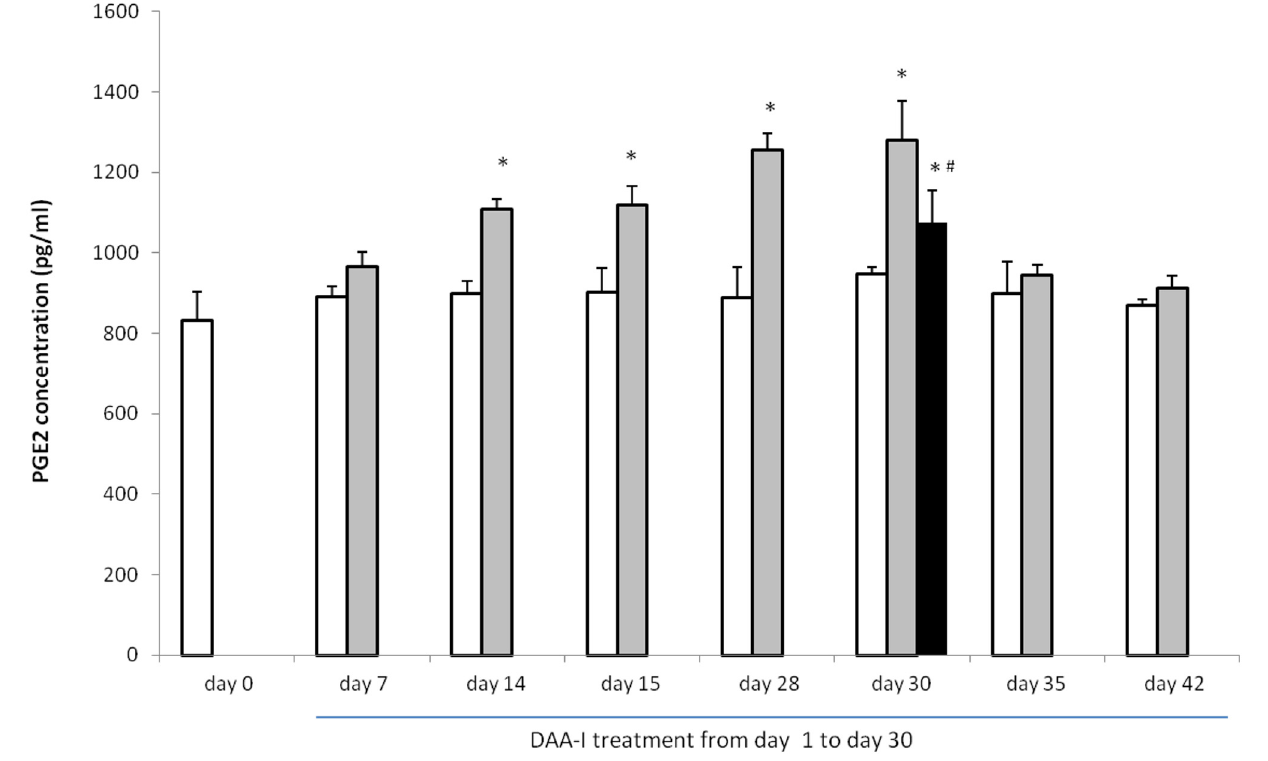
Fig 5. Temporal profile of circulating PGE 2 in mice treated with 800 nmole/kg DAA-I. Hollow histograms represent values obtained from mice that were administered vehicle, light solid filled histograms represent values obtained from mice that were administered DAA-I, and the dark solid filled histogram represents value obtained from mice that were administered DAA-I and losartan. Three animals were sacrificed at 1 hour post DAA-I or vehicle administration on the day indicated except on day 15 where the animals were sacrificed without DAA-I or vehicle administration. Each value is a mean ± S.E.M. obtained from 3 animals. Comparisons between groups were analyzed by One-Way ANOVA followed by Tukey ’ s post-hoc test. * p < 0.05 vs day 0; # p < 0.05 vs DAA-I day 30.